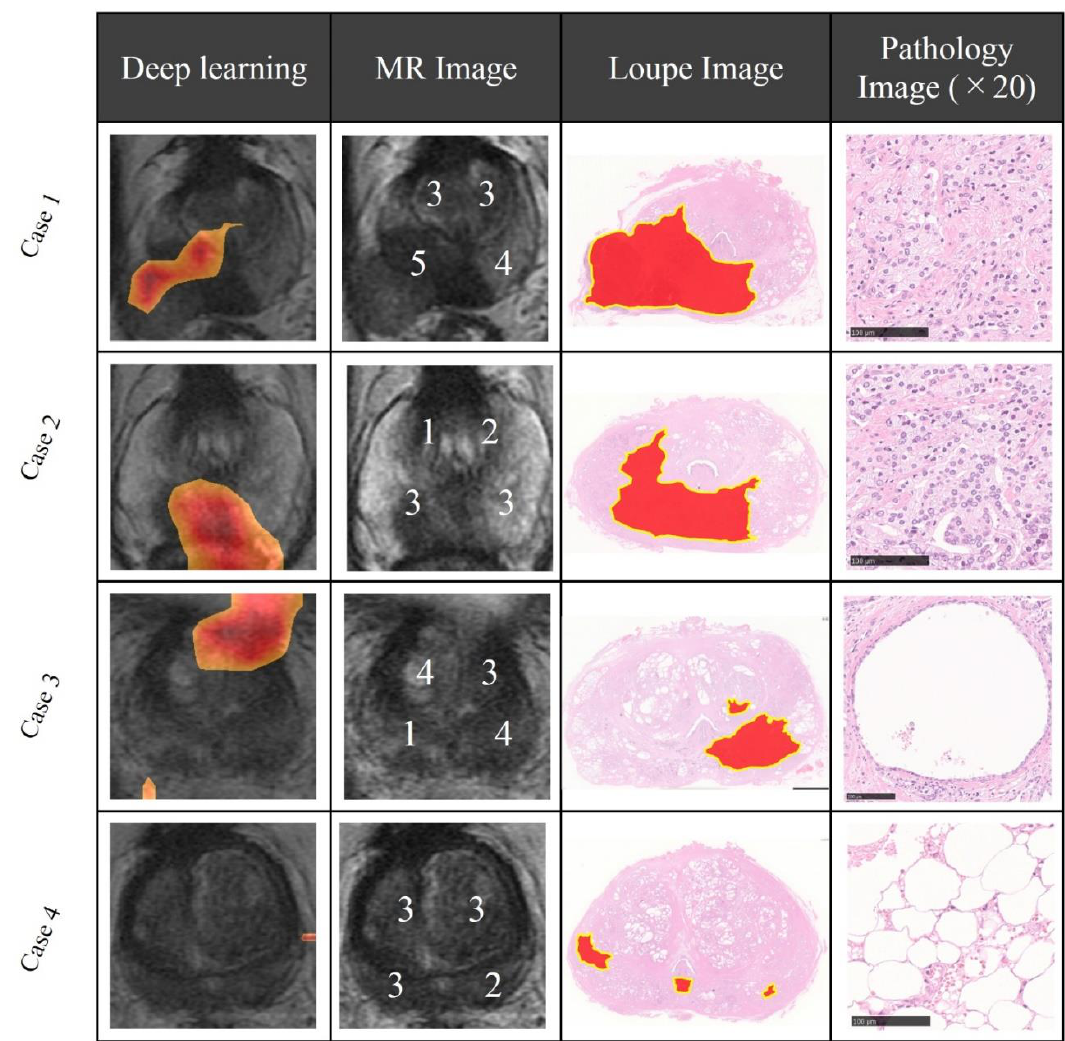
Figure 4. Representative cases of deep learning-focused regions and expert-identified cancers. Left: Deep learning focused regions. Second left: MR image with PI-RADS score. Second right: Loupe image of pathology slides (red area indicates cancer locations). Right: Representative pathological image in the deep learning-focused region ( × 20). Details of each cases are shown in Supplementary Table S1. MR image = Magnetic resonance image, PI-RADS = Prostate imaging reporting and data system.